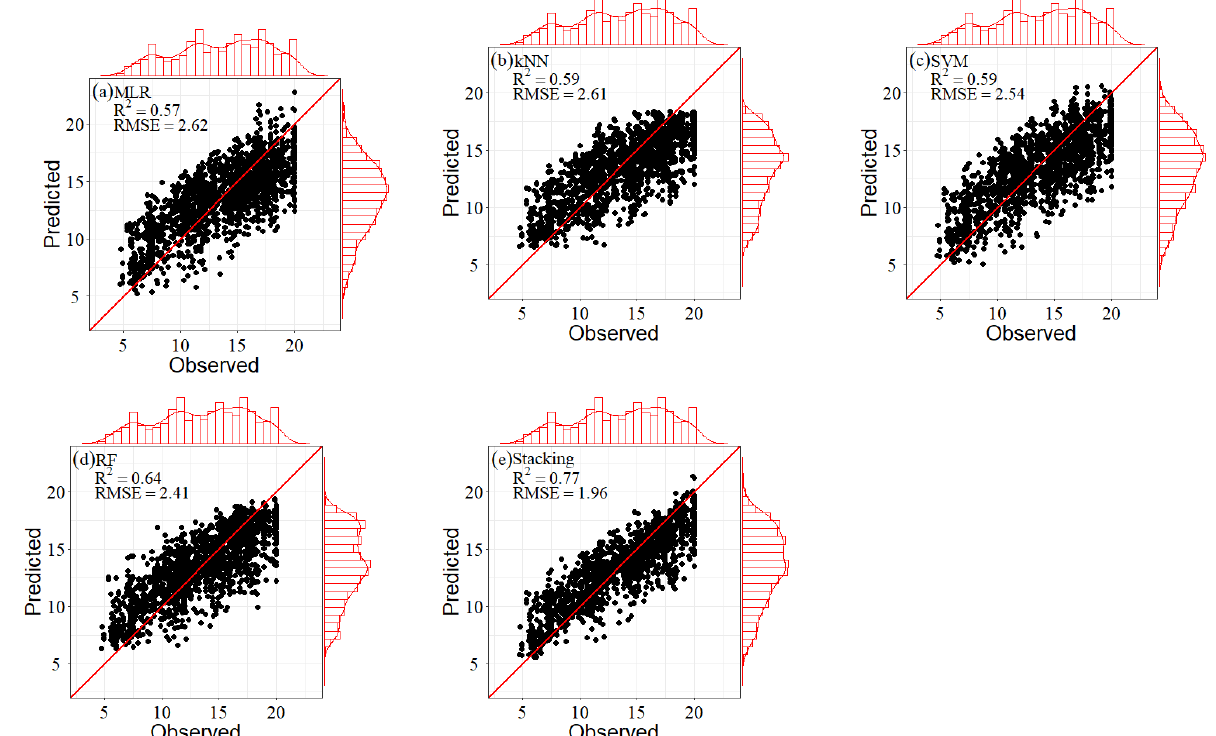
Figure 6. Scatter plots of the predicted forest canopy height against the observed values in Saihanba using: ( a ) MLR; ( b ) k NN; ( c ) SVM; ( d ) RF; ( e ) stacking.